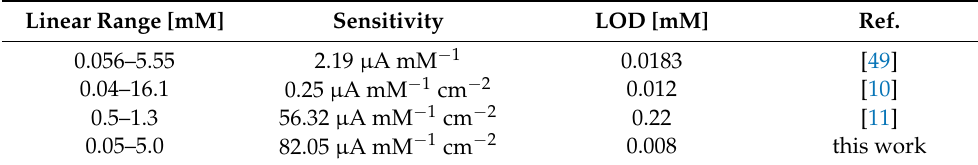
Figure 4. Calibration curve obtained by adding six times 0.05 mM, five times 0.1 mM, six times 0.2 mM, and six times 0.5 mM aliquots of glucose standard solutions prepared in 0.1 M phosphate buffer solution, with pH 7.4, at operating potential 0.4 V. The insert shows the amperogram of the same measurement. Table 1. Comparison of the main sensor parameters for previously reported glucose sensors and our work.